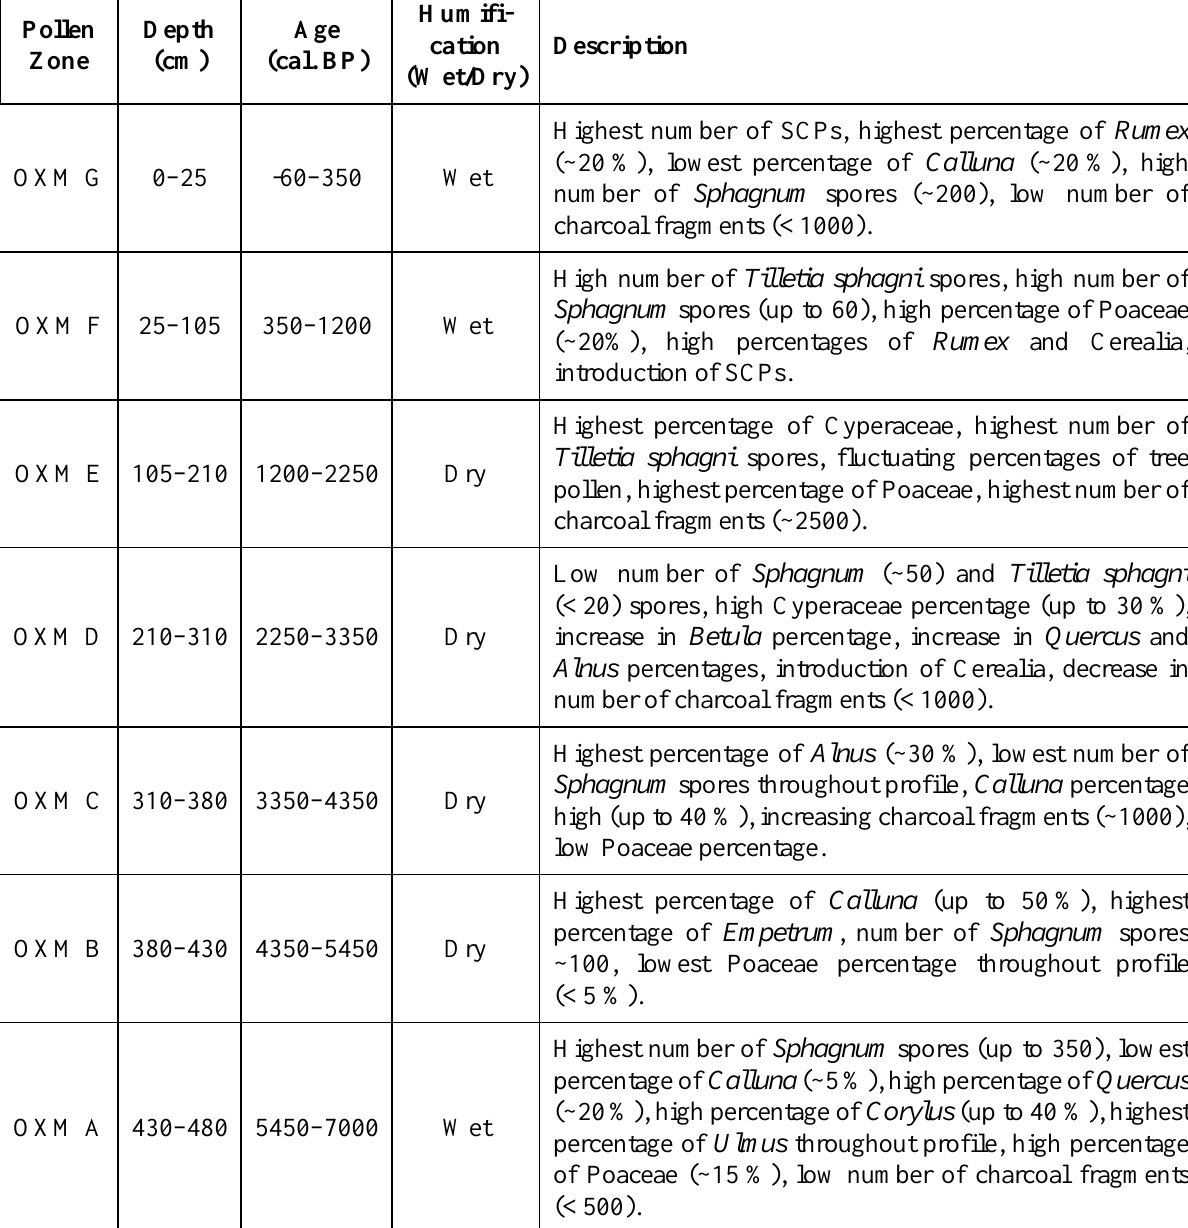
Table 2. Pollen zone descriptions using depth (cm), radiocarbon ages (cal. BP) and humification (Wet/Dry). Pollen Depth Zone (cm) (cal. BP)